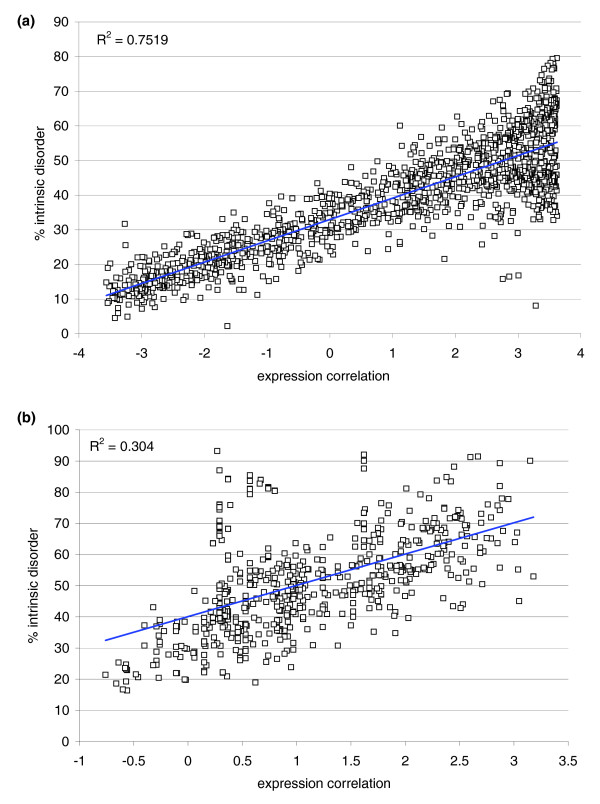
(η-disorder) correlation for yeast and human protein interactions. Correlation between η-parameter and percent predicted disorder (disorder content) of the most disordered domain for each of (a) the 1,354 Pfam-filtered protein-interaction pairs in yeast and (b) the 607 pairs in human.